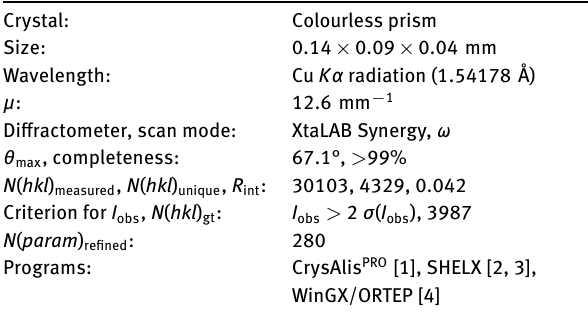
Table 1: Data collection and